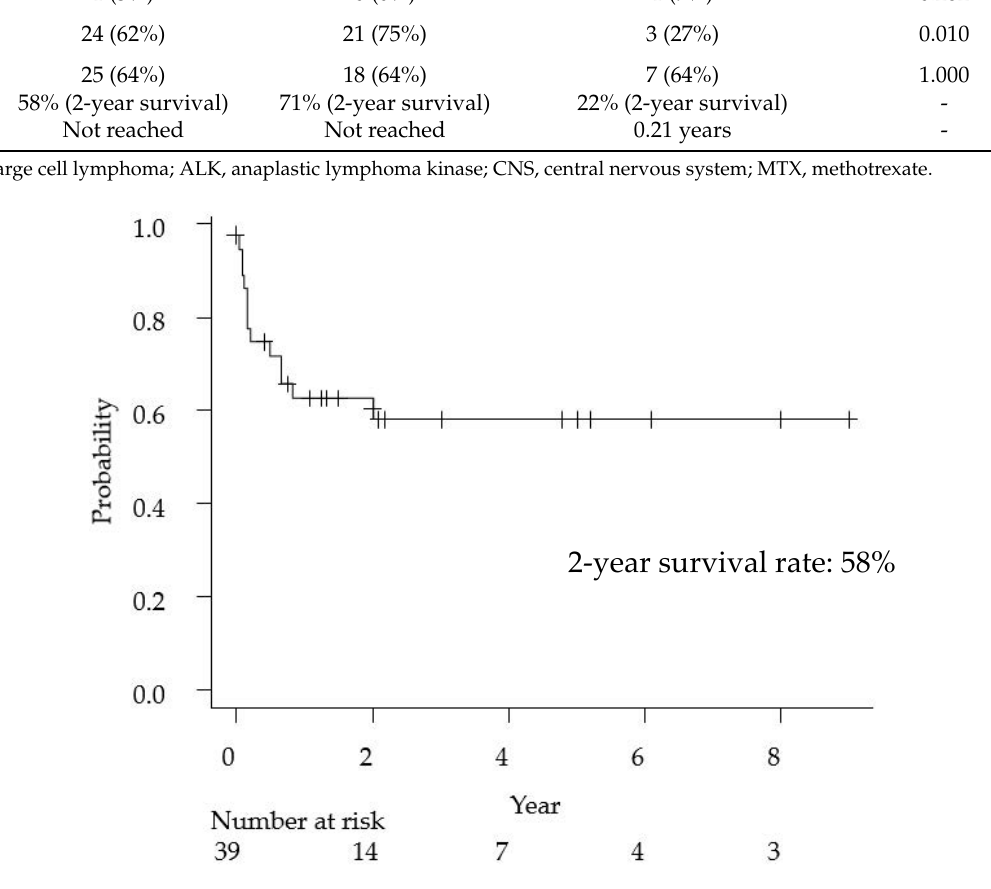
Figure 2. Kaplan-Meyer curve for overall survival following primary anaplastic large cell lymphoma of the central nervous system.